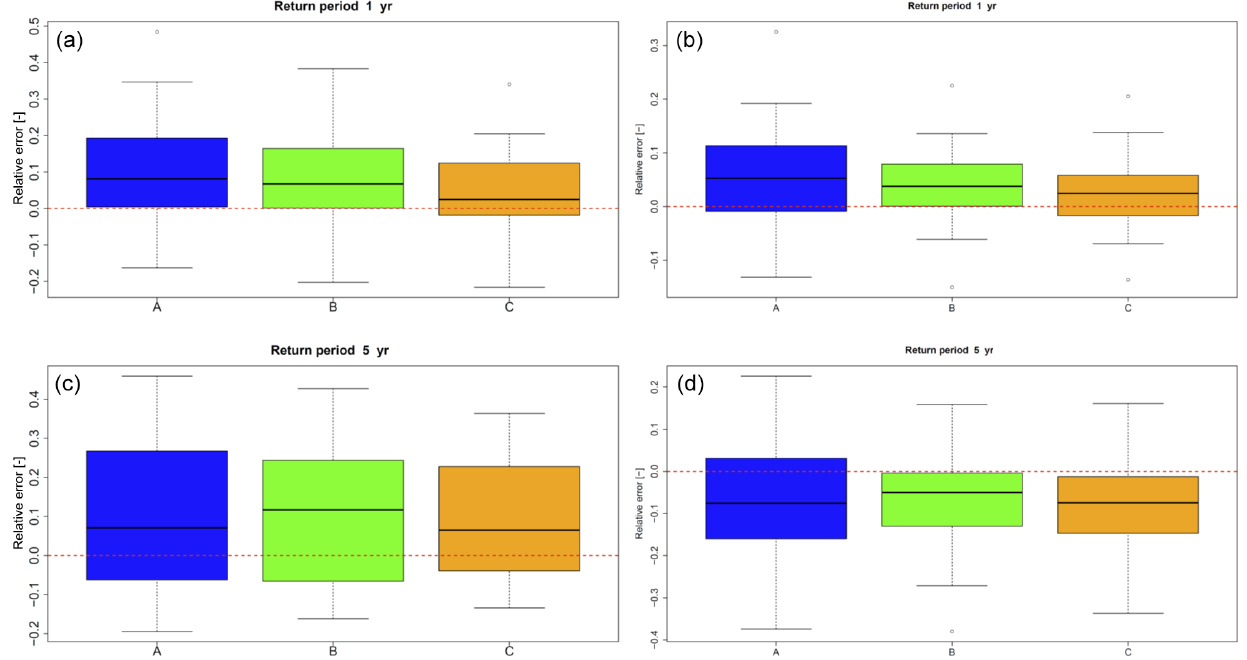
Figure 10. Mean relative errors of extreme values of the disaggregated time series for all stations (the dashed line represents an error of 0). Results are shown for durations of 5min (a, c) and 1h (b, d) and for return periods of 1 year (a, b) and 5 years (c, d) .